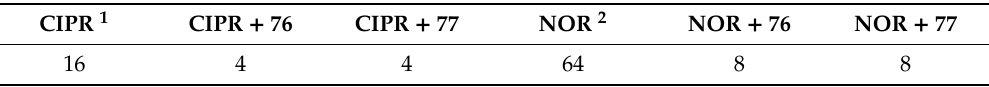
Table 6. Minimum modulatory concentration (MMC, μ g/mL) of ciprofloxacin and norfloxacin when alone or combined with compounds 76 or 77 .